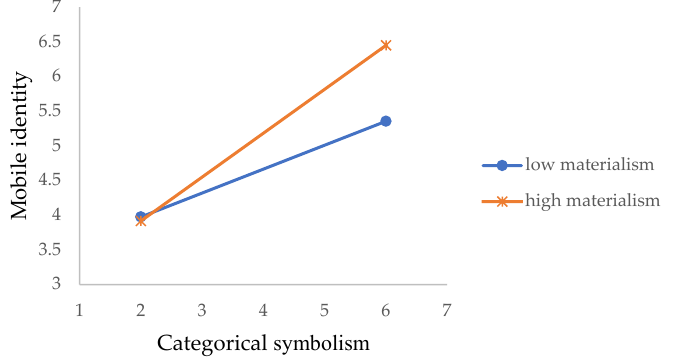
Figure 5. Interaction effect between categorical symbolism and individual materialism.